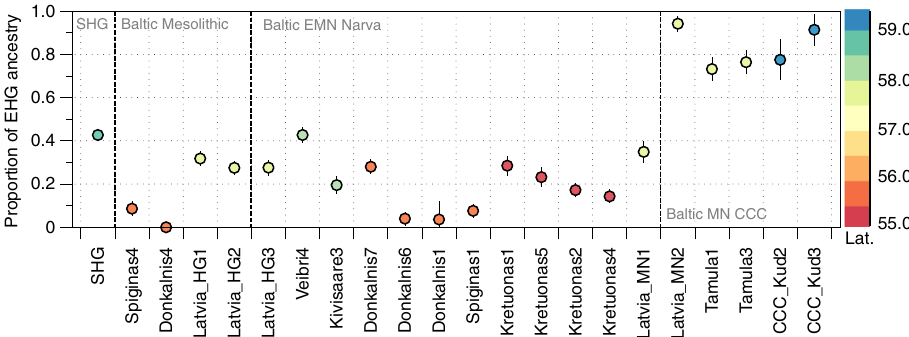
Fig. 3 EHG ancestry in SHG and Eastern Baltic hunter-gatherers. Ancestry proportions were estimated with qpAdm , and standard errors are shown as vertical lines. Colours indicate latitude of the site at which the individuals were